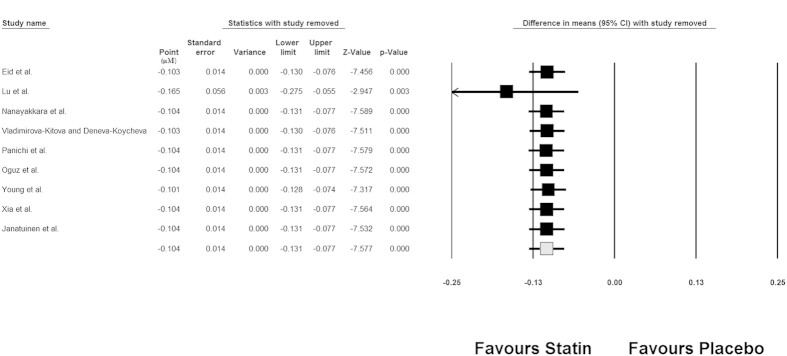
Leave-one-out sensitivity analysis for the impact of statin therapy on plasma concentrations of ADMA.